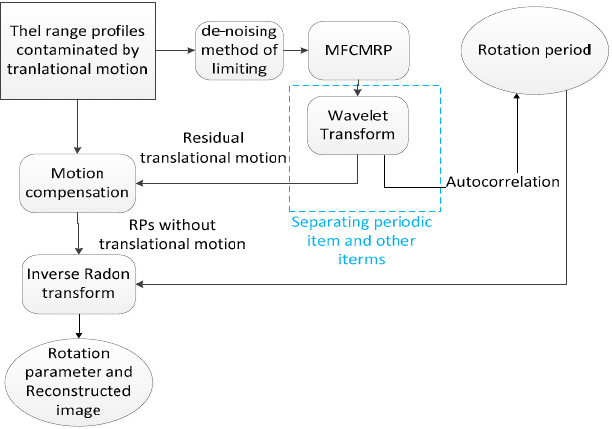
Figure 1. The specific procedures of whole parameter estimated method.